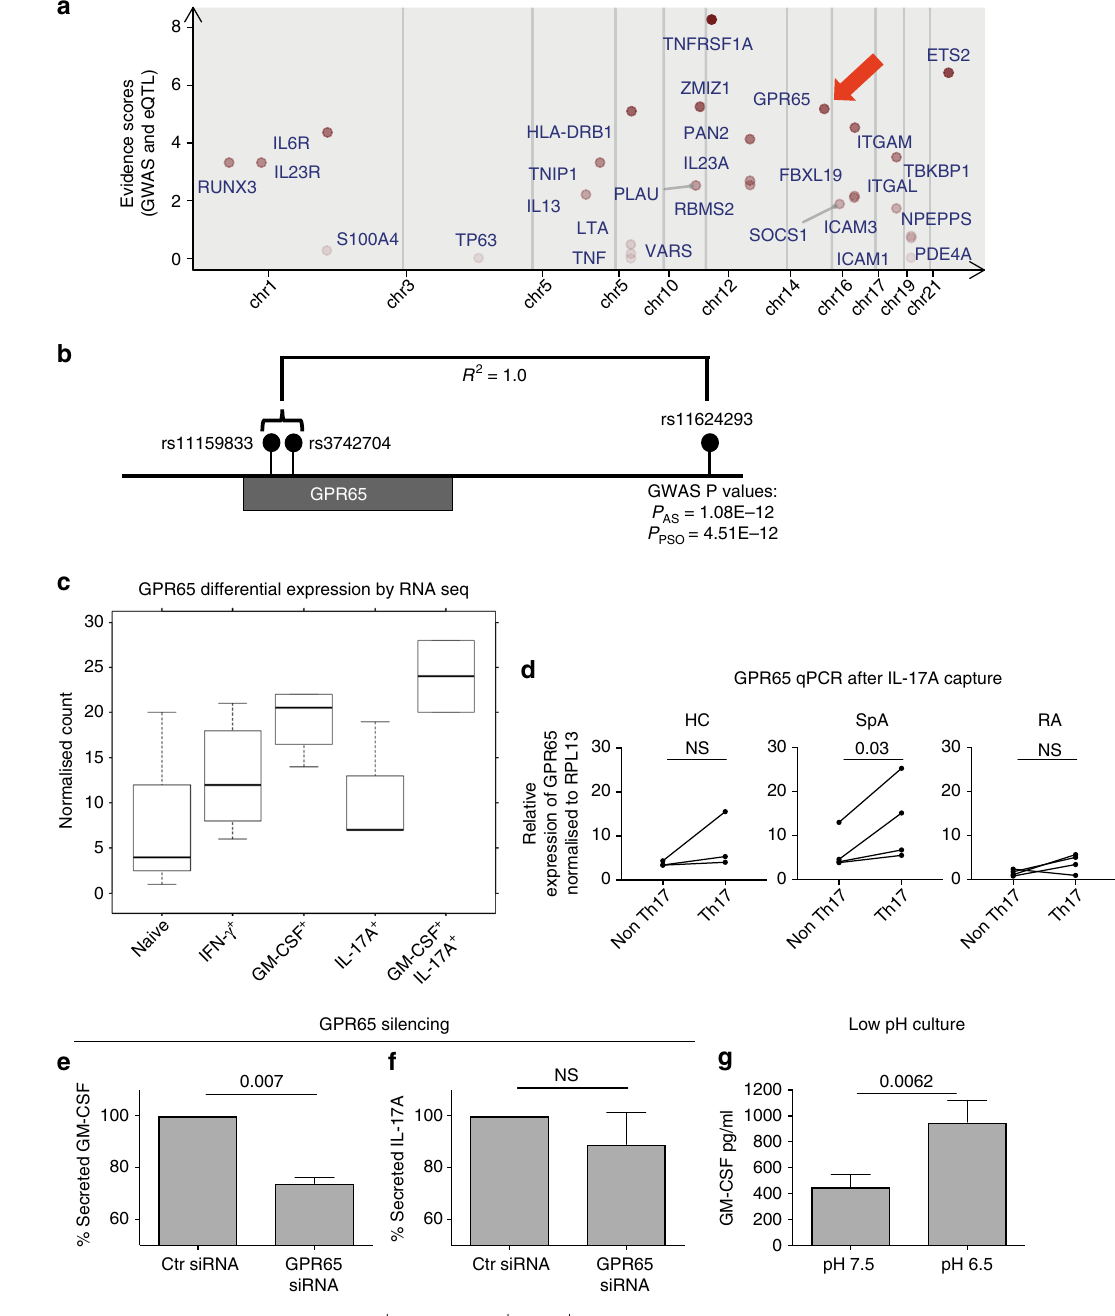
Fig. 5 GPR65 expression is associated with GM-CSF + and GM-CSF + IL-17A + CD4 T cells. a Evidence score analysis showing top ranking genes identi fi ed in GM-CSF + and IL-17A + GM-CSF + cells. Red arrow shows GPR65 b Location of AS and psoriasis-associated GPR65 single-nucleotide polymorphism rs11624293 in relation the two SNPs identi fi ed in eQTL data sets. c Expression of GPR65 in RNA sequencing analysis of the 5 sorted primary T cell populations isolated by multiple cytokine capture ( p = 0.012, ANOVA). d Expression of GPR65 by qPCR in ex vivo IL-17A − and IL-17A + cytokine captured CD4 T cells from patients and controls (paired t -tests). GM-CSF e and IL-17A f measured by ELISA in culture supernatants of primary human CD4 cells in the presence GPR65 siRNA or control siRNA (mean + SEM, paired t -tests). g GM-CSF was measured by ELISA in culture supernatants of primary human CD4 cells cultured at a pH of 7.5 or in media acidi fi ed to a pH of 6.5 for 72 h (mean+ SEM, paired t -tests) Statistical analysis . Prism version 6 was used for statistical analysis. When Prioritisation of key genes . We applied an in-house prioritisation system using comparing two unpaired groups with normal distribution of data a two-tailed random forest plot modelling 57 to generate evidence scores prioritising key genes unpaired t -test was used for statistical analysis. When comparing two unpaired involved in spondyloarthritis. We utilised GWAS summary data (risk variants and groups with data that was not normally distributed a Mann – Whitney test was used. their detected p -values) for susceptibility in spondyloarthritis 58,59 and eQTL For paired data, a paired t -test and Wilcoxon matched-pairs signed-rank tests were summary data 60,61 to prioritise the 1643 genes that were differentially expressed in used for parametric and non-parametric data, respectively. When comparing more GM-CSF + CD4 cells from our data set. We prioritised genes based upon the than two unpaired groups, a one-way analysis of variance (ANOVA) with Bon- relative weight of evidence of GWAS association and the eQTL signi fi cance level ferroni ’ s correction was used for parametric data. Where the data were not linking a SNP to a gene. NATURE COMMUNICATIONS | 8: 1510 | DOI: 10.1038/s41467-017-01771-2 |